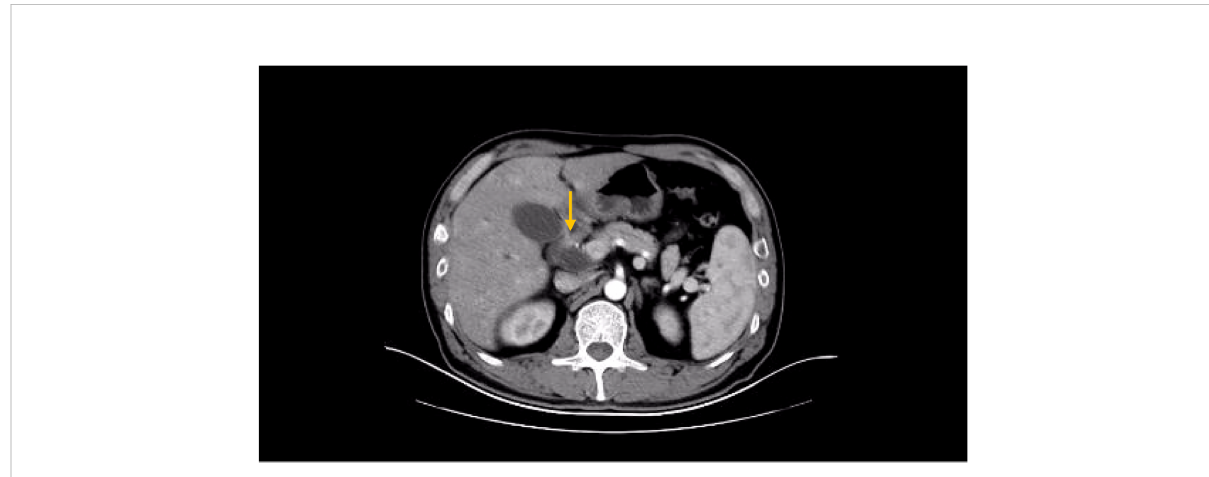
FIGURE 1 CT before operation (the tumor is located around the head of the